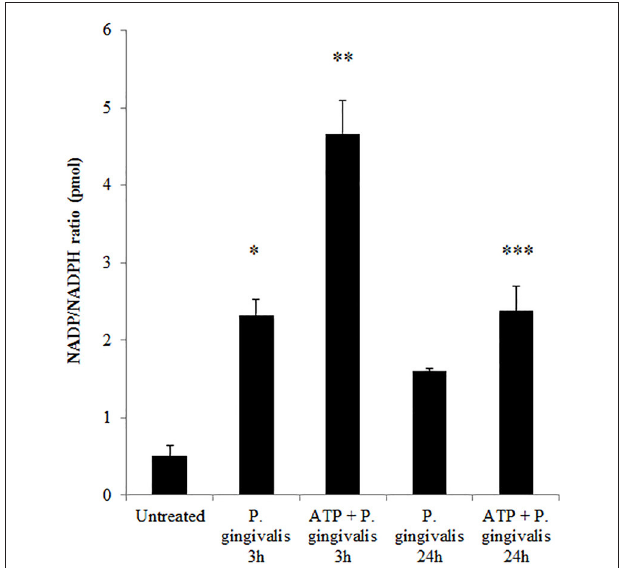
FIGURE 4 | P. gingivalis modulates NADPH consumption in GECs. Measure of NADP/NADPH ratio in P. gingivalis (MOI100) infected GECs with or without ATP (3 mM) pre-treatment. N = 3, * p < 0.05, ** p < 0.01, 3 h P. gingivalis infection and ATP with 3 h infection as compared to untreated; *** p < 0.01 ATP with 24 h infection decrease as compared to ATP with 3 h